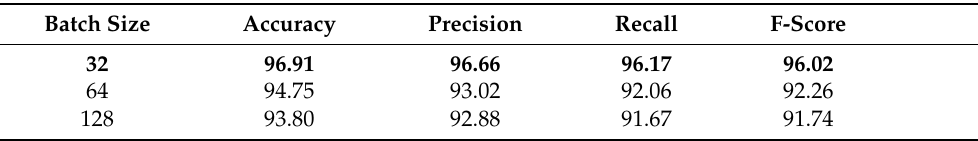
Table 3. Average recognition performance of the proposed KinectGaitNet with ReLU activation functions, Adam optimizer, and different batch sizes on the UPCV dataset. The best performance is shown in